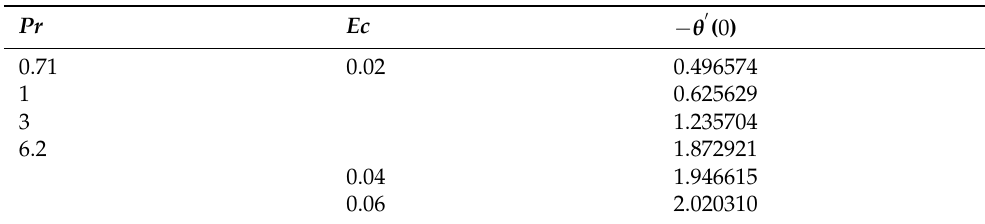
Table 3. Calculations of − θ (cid:48) ( 0 ) for diverse Ec and Pr quantities with M = 0.1, Sc = 0.22, K = 0.2, Kc = 0.1, and β = 1.